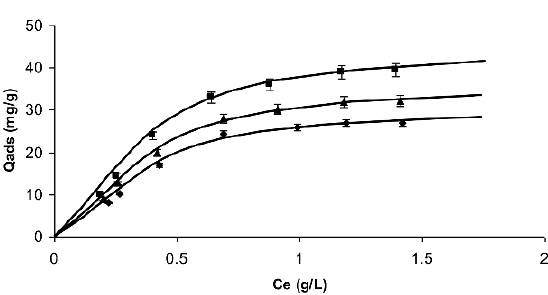
Figure 4. Adsorption isotherms of phenol in HBEA zeolite at 20°C ( (cid:4) ), 30°C ( (cid:78) ) and 40°C ( (cid:7) ). Lines represent fitting curves by Fowler-Guggenheim